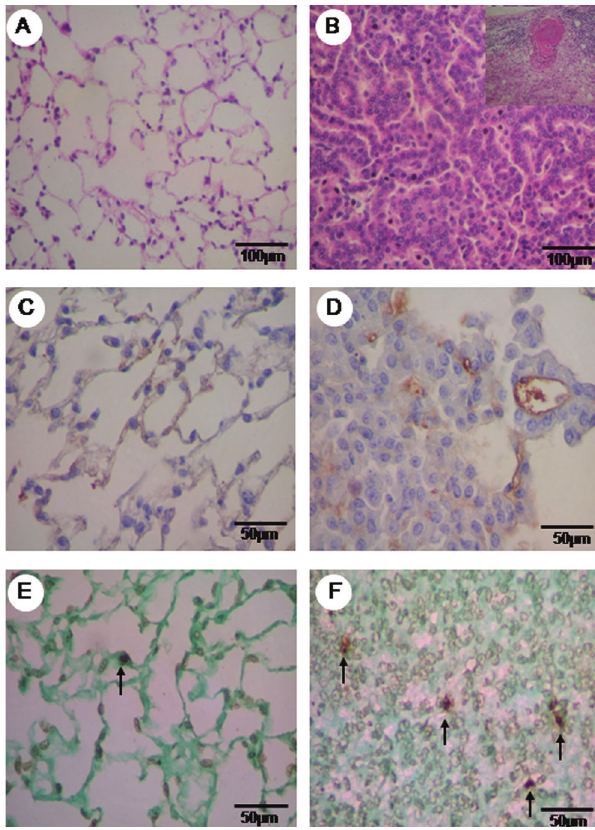
Figure 1 - Hematoxylin eosin (HE) staining of normal parenchyma of the control group (A) and the urethane group, with an adenocarcinogenic area and the detail of the adenocarcinogenic metastasis of the lymph node (B). Vascular caspase 9 is minimally immunolabeled in the control group (C) and shows major expression in the tumor parenchyma (D). Minimal TUNEL (+) staining is observed in the normal area (E) of the control group TUNEL staining is increased in the tumor parenchyma (F). HE in A,B is at 200x, immunohistochemistry for caspase 9 in C,D is at 400x and TUNEL (+) apoptosis in E,F is at 400x